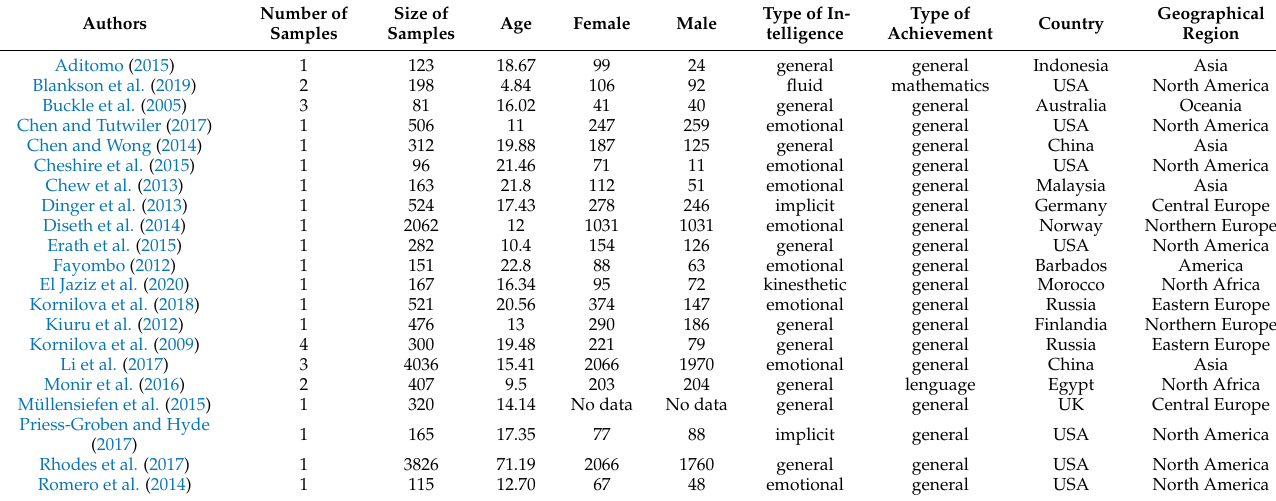
Table 1. Sociodemographic